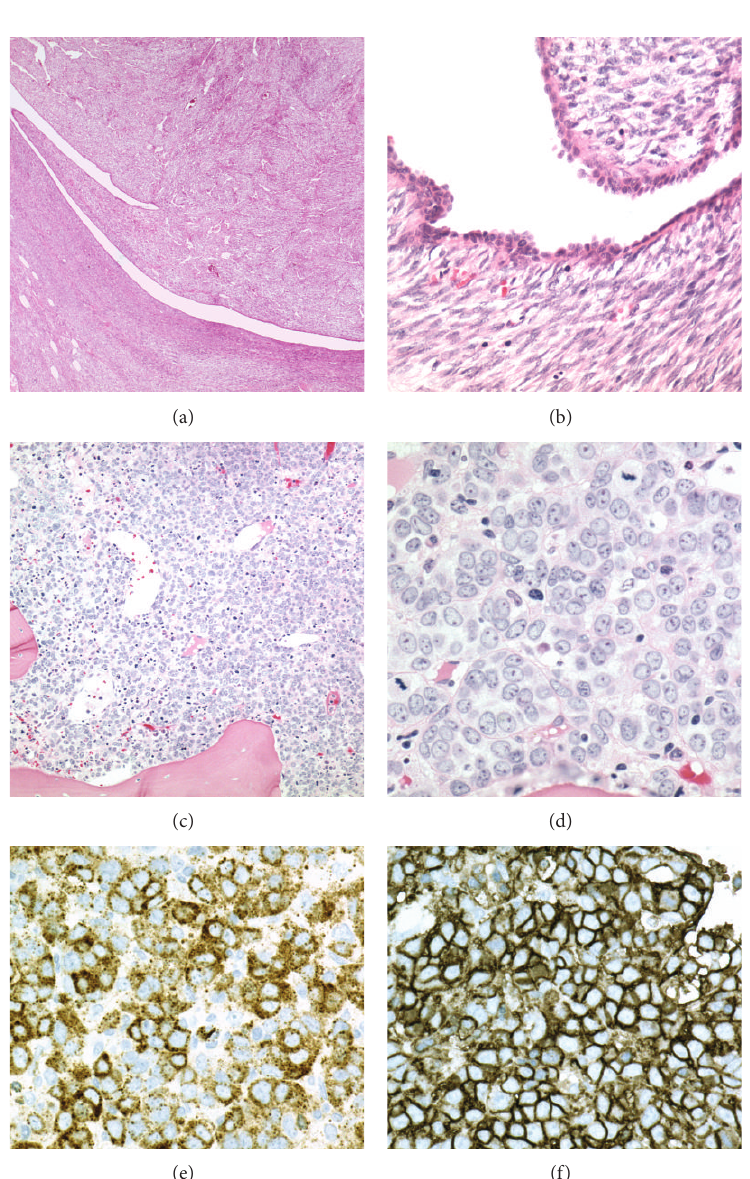
Figure 1: Histology of the malignant phyllodes tumor (panels (a) and (b)) and acute megakaryocytic leukemia (panels (c)–(f)). Hematoxylin and eosin staining of the phyllodes tumor showed a benign epithelial component and a malignant stromal component (panel (a) 20x and panel (b) 200x enlarged). The bone marrow was diffusely infiltrated by large blasts (panels (c) and (d), H&E-stained sections, 100x and 400x enlarged, resp.). The blasts expressed factor VIII and CD31 (panels (e) and (f), resp., immunoperoxidase-stained sections, 400x